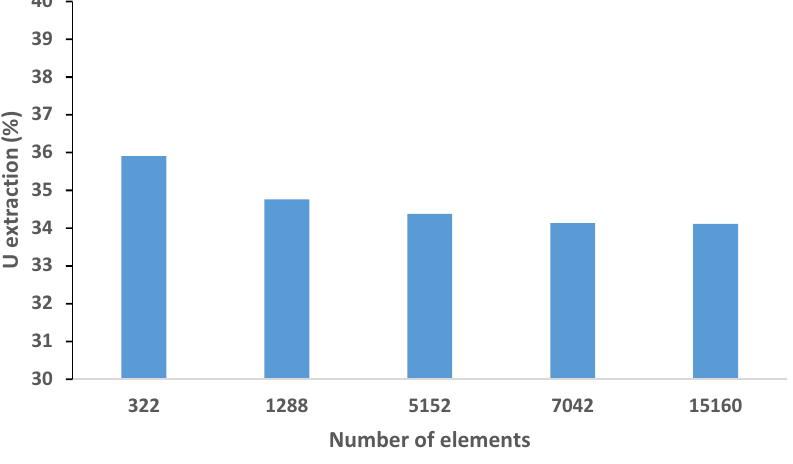
Figure 3. Mesh independence study of uranium extraction, TBP concentration = 30%, Q aq = 25 Lph, Q aq = 35 Lph.